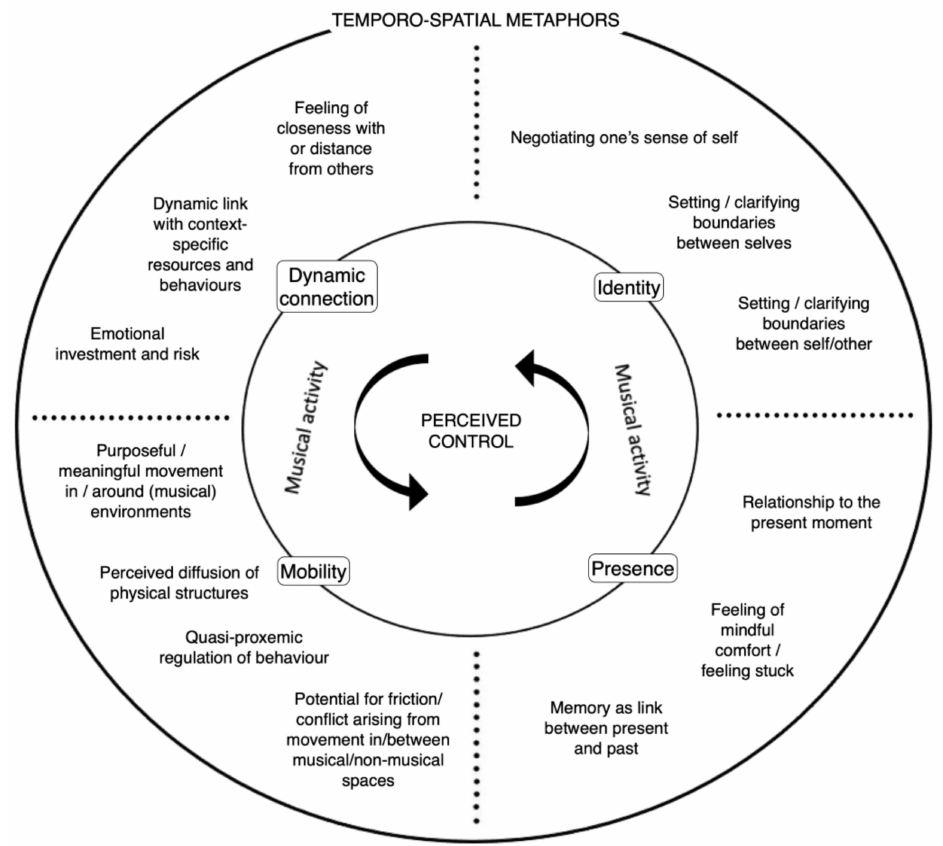
Figure 1. A thematic framework explaining music’s mediating role in adapting to and coping with conditions of social isolation during pandemic lockdown. The super-ordinate theme is represented at the centre; the four remaining themes are represented on the smaller, inner circle; the individual codes are represented in the largest, outermost circle. Musical activities shaped and were shaped by all aspects of the framework. This figure was developed by the authors for illustrative